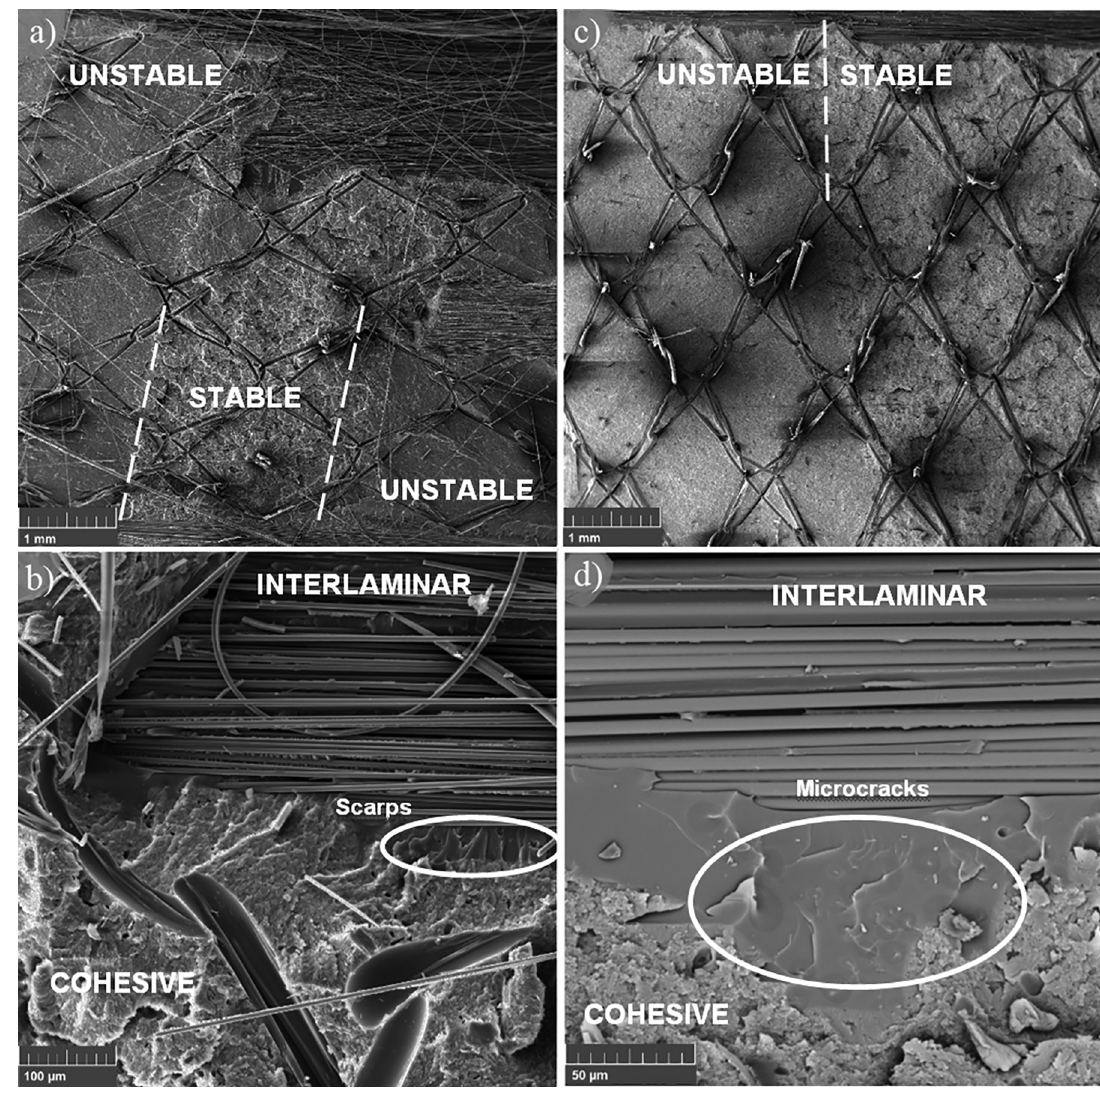
Figure 6. SEM images of: a and b) co-bonded; c and d) secondary bonding specimens. Magnification of 50x, 500x, 50x and 1000x, respectively